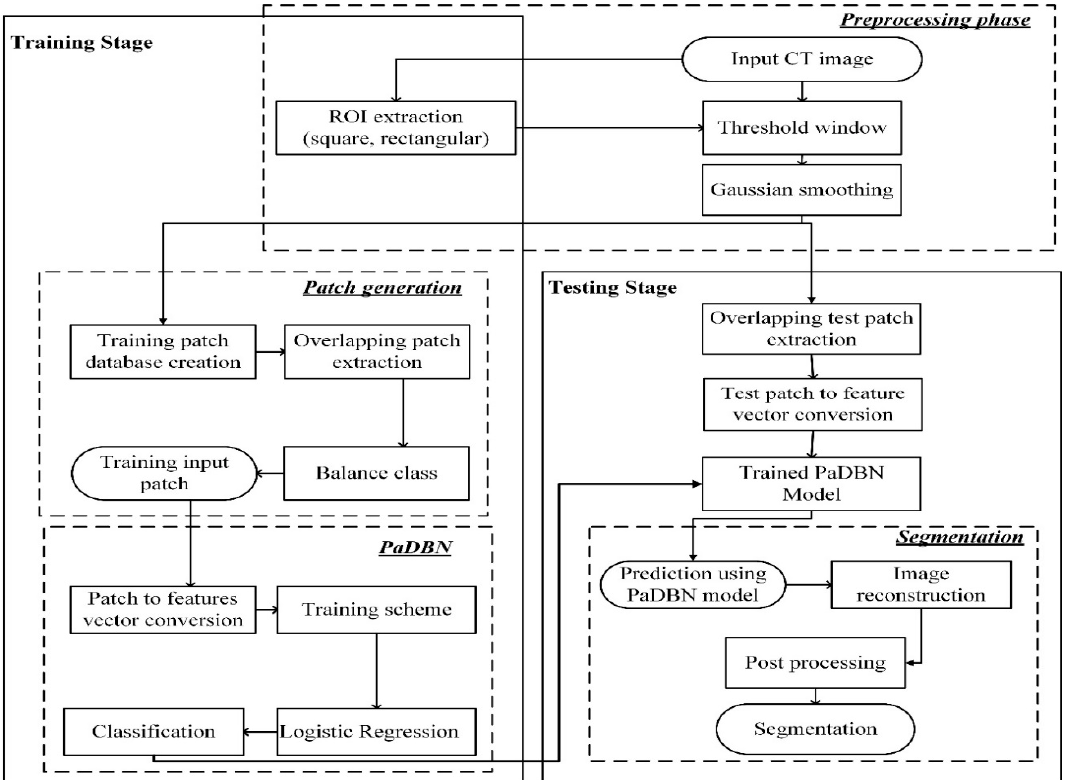
Figure 1. The proposed patch-based deep belief networks (PaDBN) model for vertebrae segmentation.